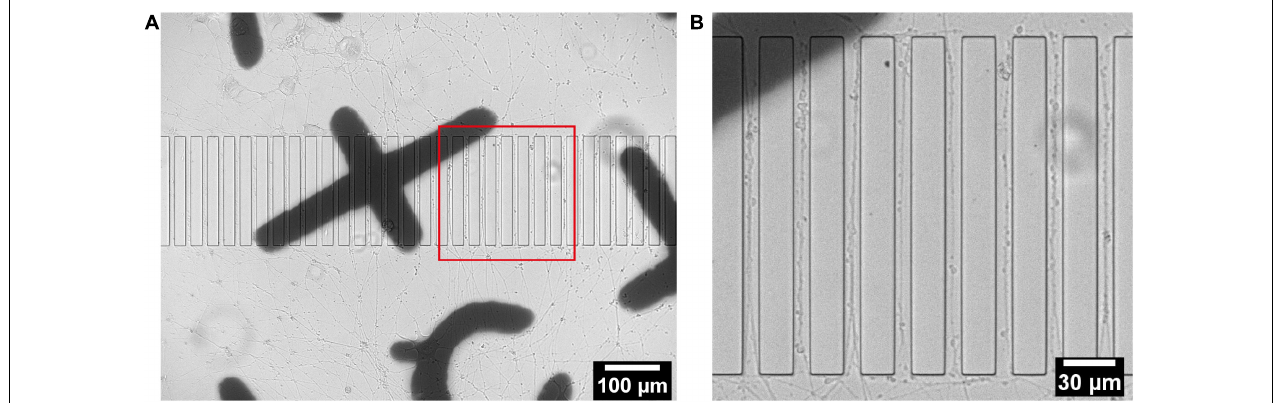
FIGURE 2 | Live imaging of differentiated PC12 cells growing on a structured sapphire disk coated with collagen type IV. (A) Projections from differentiated PC12 cells were guided to grow into channels between ridges. (B) Zoomed-in red box in (A)